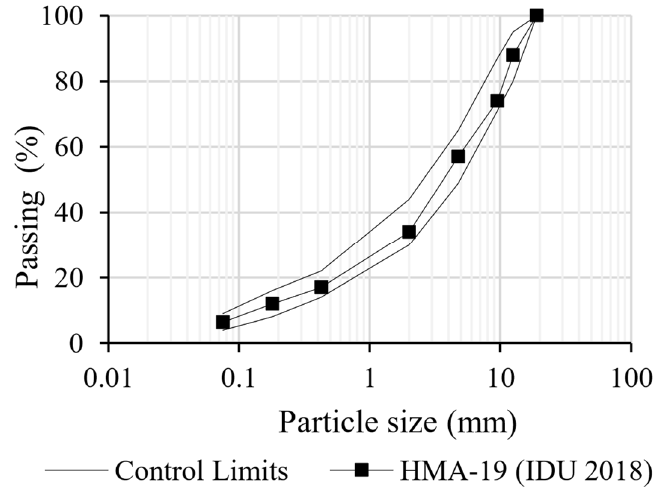
Figure 1. Particle size distribution curve for the asphalt mixture.